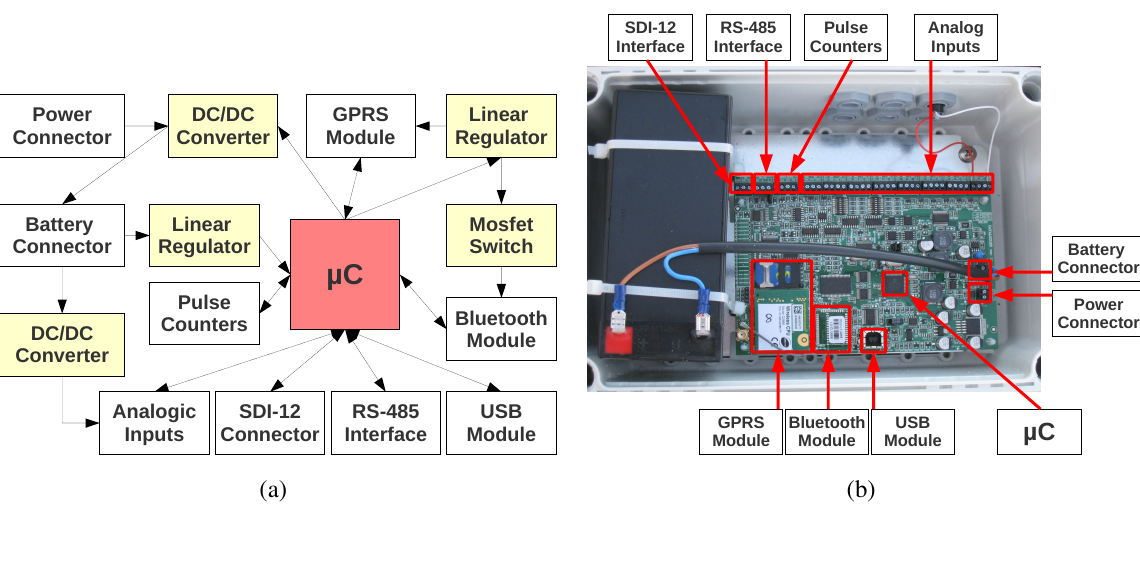
Figure 2. Two different views of the DatalogV1. ( a ) Block diagram showing the main